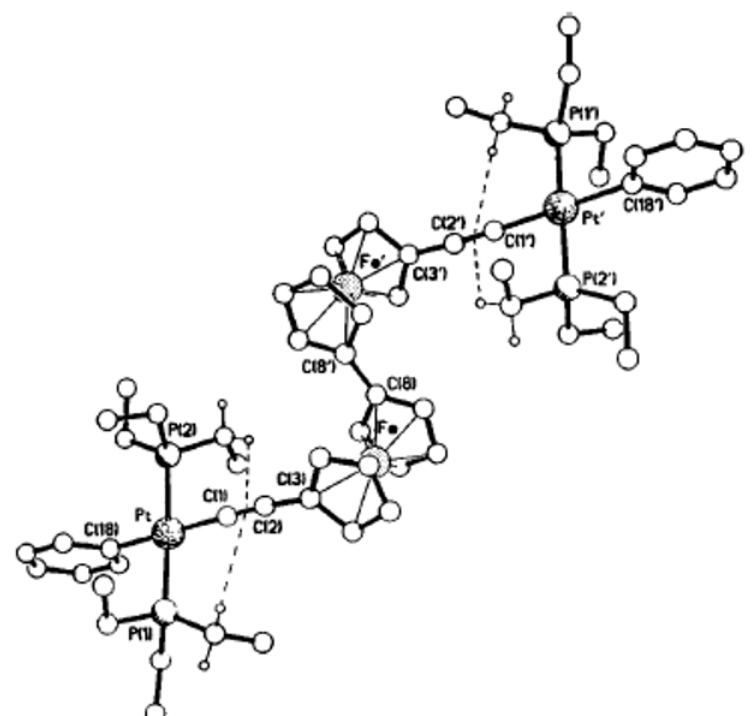
Figure 8. Structure of [{PEt